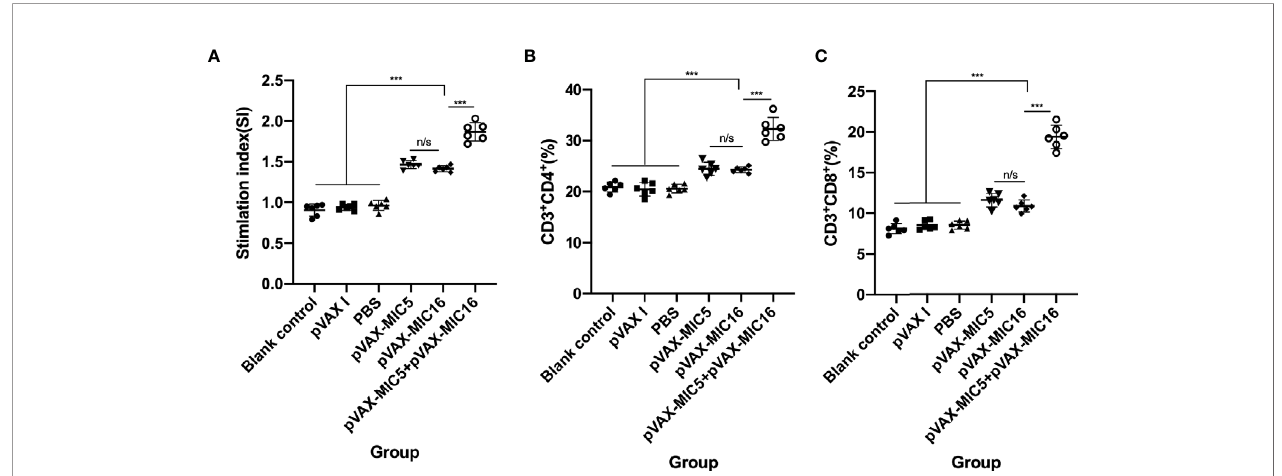
FIGURE 3 | Splenocyte proliferative response and the percentages of CD4 + and CD8 + of T cells in immunized and control mice two weeks after the challenge. (A) Lymphocyte proliferation stimulation index (SI). (B, C) Determination of the percentages of CD4 + or CD8 + T cells in immunized and control mice. *** P < 0.001, “ n/s ” , no signi fi cant. Data are presented as the means ± SD.